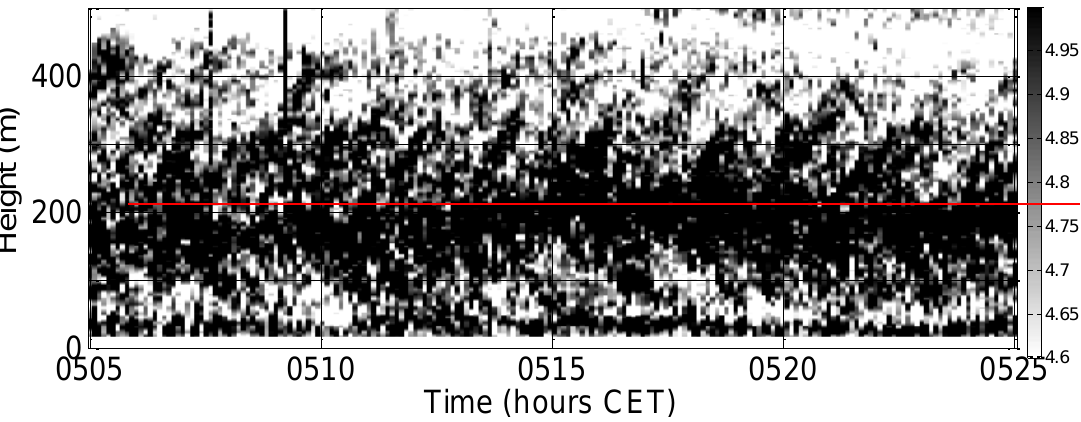
Figure 31. Close-up of the echogram from Figure 22, showing the presence of KHBs below and above the height of the wind speed maximum (red line). Braid-like thin turbulent layers are tilted in opposite directions, depending on the vertical gradient (positive or negative) of wind speed (12 August 2015, 0505–0525 CET).